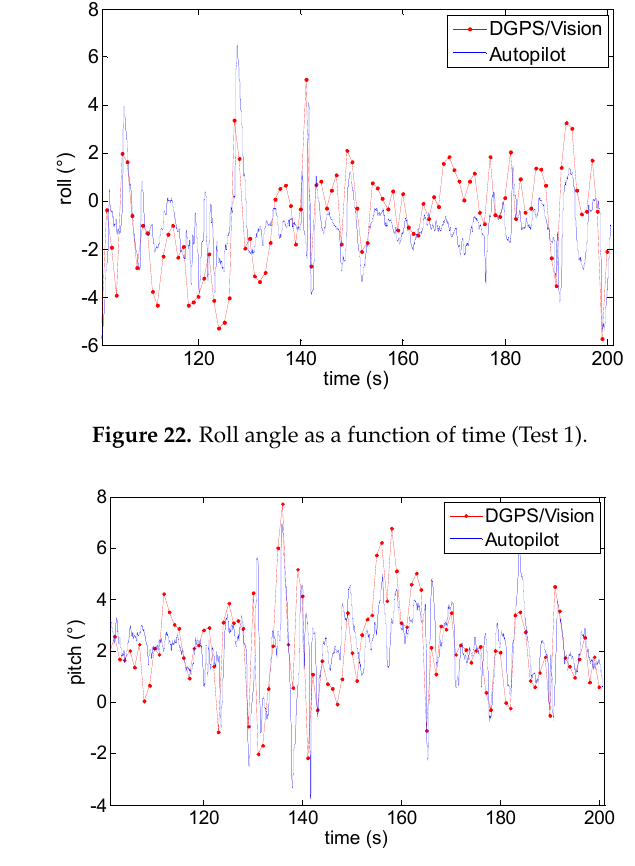
Figure 23. Pitch angle as a function of time (Test 1).